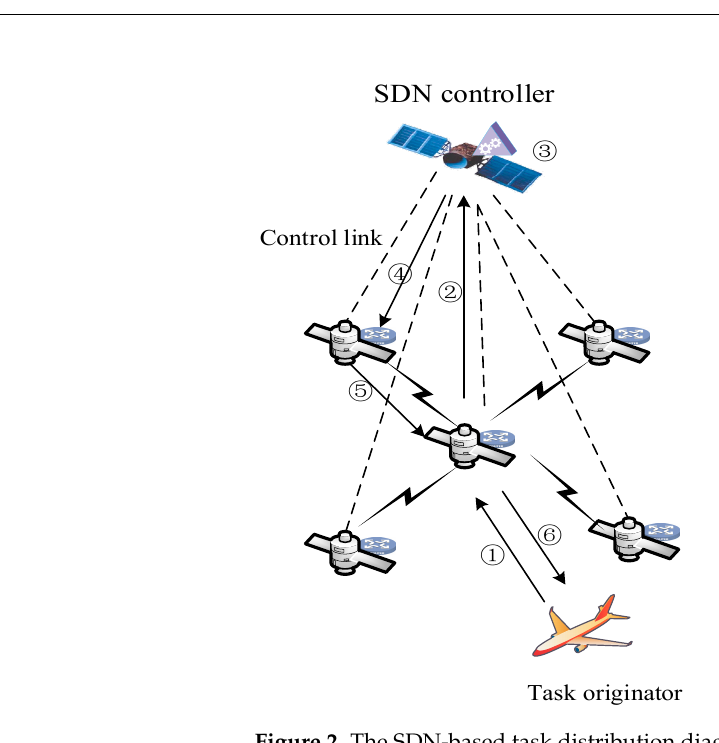
Figure 2. The SDN-based task distribution diagram.